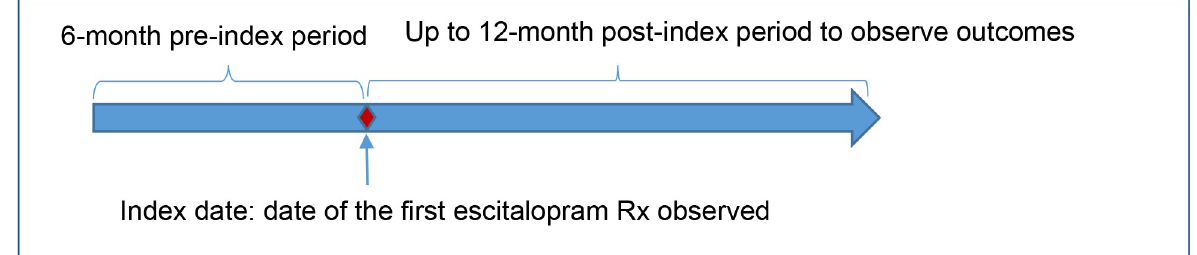
Fig 1. New user cohort study